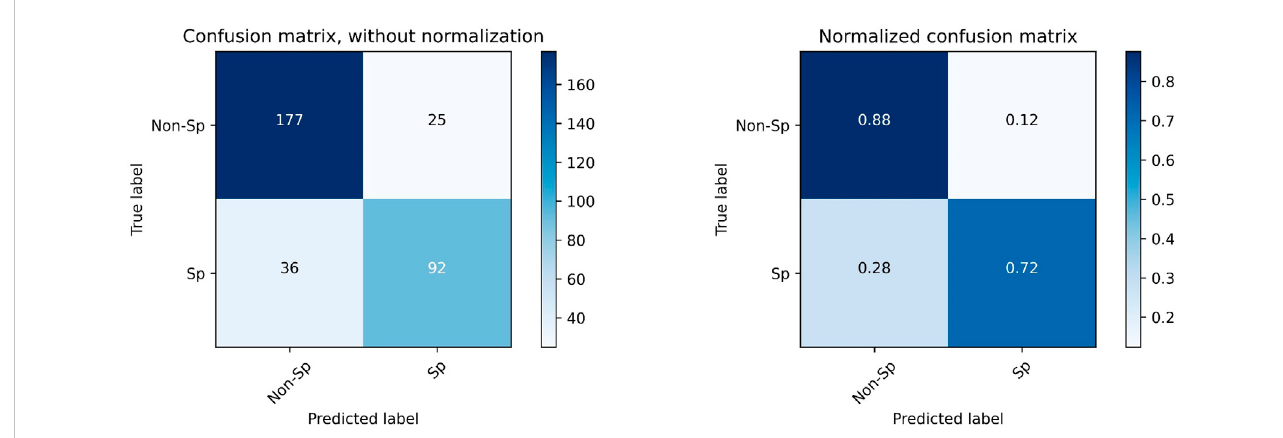
FIGURE 5 Confusion matrix for the prediction of sarcopenia with SMI = 38.5 as the cutoff value. “ Sp ” refers to sarcopenia, and “ Non-Sp ” refers to non-sarcopenia.